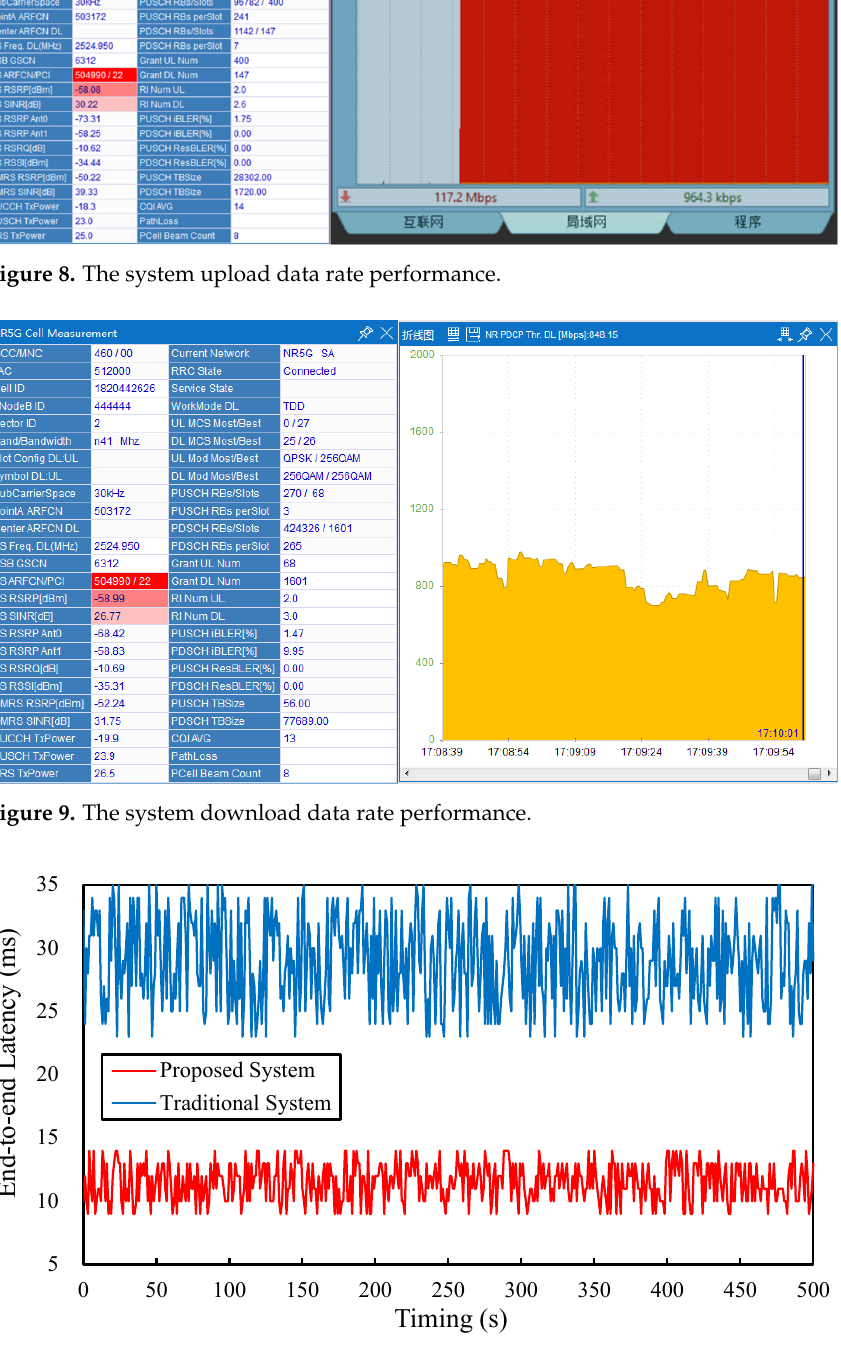
Figure 10. The system end-to-end latency